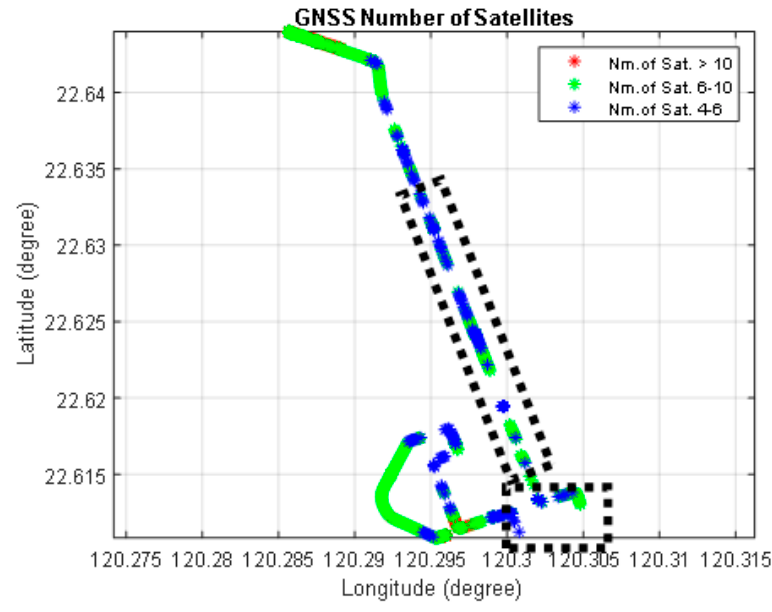
Figure 8. Di ff erential GNSS solution encoded by the number of satellites in an urban area.